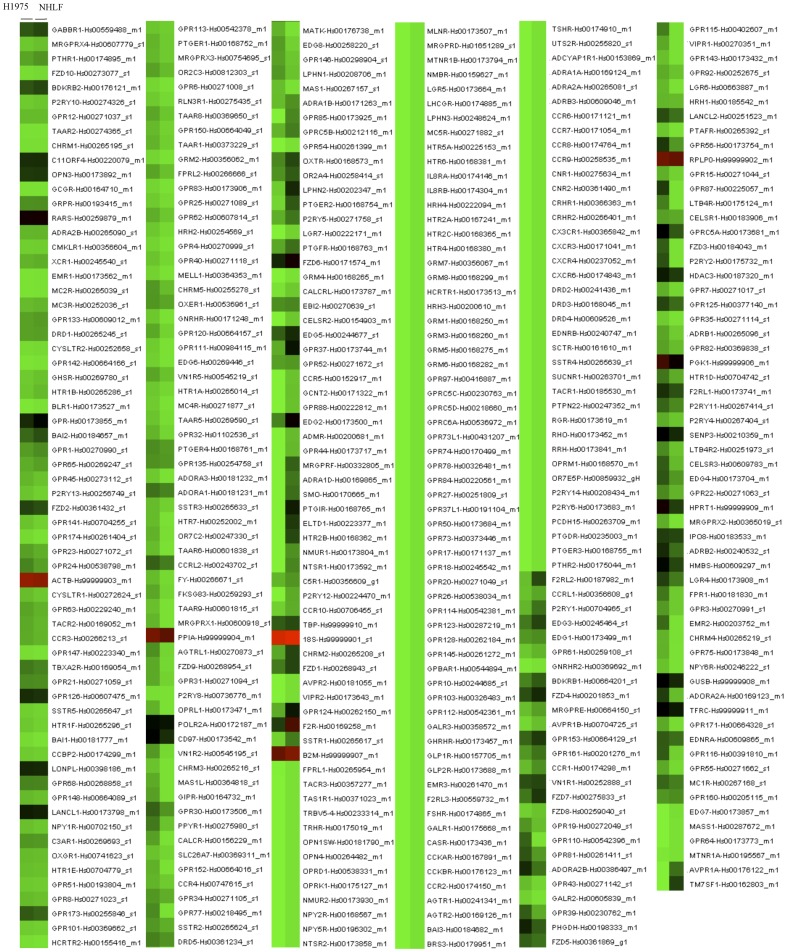
Heatmap of 384 human GPCR differentially expressed in H1975 cells compared to NHLF cells.Each GPCR is shown as a single bar based on their Ct values and color coding is shown below, with a gradient from green (negative and lowest Ct values) to red (positive and highest Ct values).